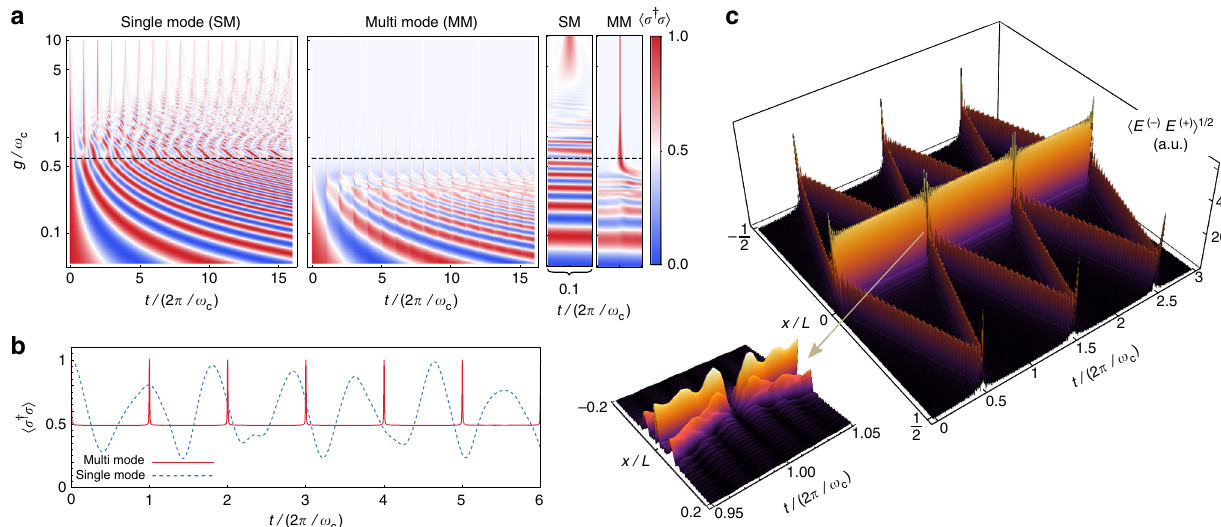
Fig. 2 Breakdown of the Rabi model observed through the system dynamics. a Contour plot of the TLS population versus time and coupling rate. The dashed line marks the value g / ω c ≈ 0.6 chosen for the rest of the simulations. Above this value, the single-mode Rabi model differs drastically from the multi-mode model. Insets on the right show a zoom view around a revival peak. b Population of an initially excited TLS versus time for the single-mode (blue, dashed) and multi-mode (red, solid) cases, for a coupling rate of g / ω c = 0.6. c Amplitude of the electric fi eld inside the cavity (square root plotted for clarity) as a function of space and time, for g / ω c = 0.6. The inset focus on the precise moment when the fi eld is perfectly absorbed by the emitter, giving rise to the revival peaks in the population of the TLS. Computed using the technique of MPS including 50 cavity